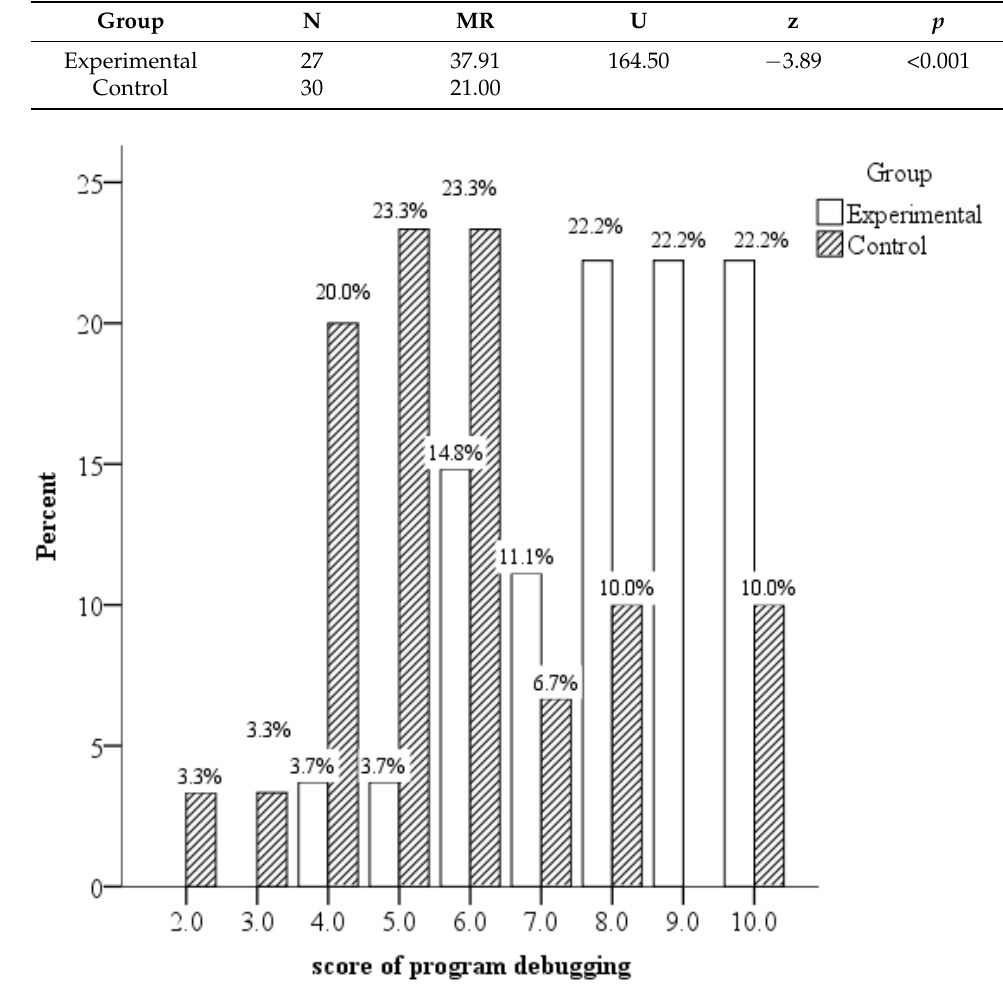
Table 7. Result of the Mann-Whitney U test of the DBG scores.